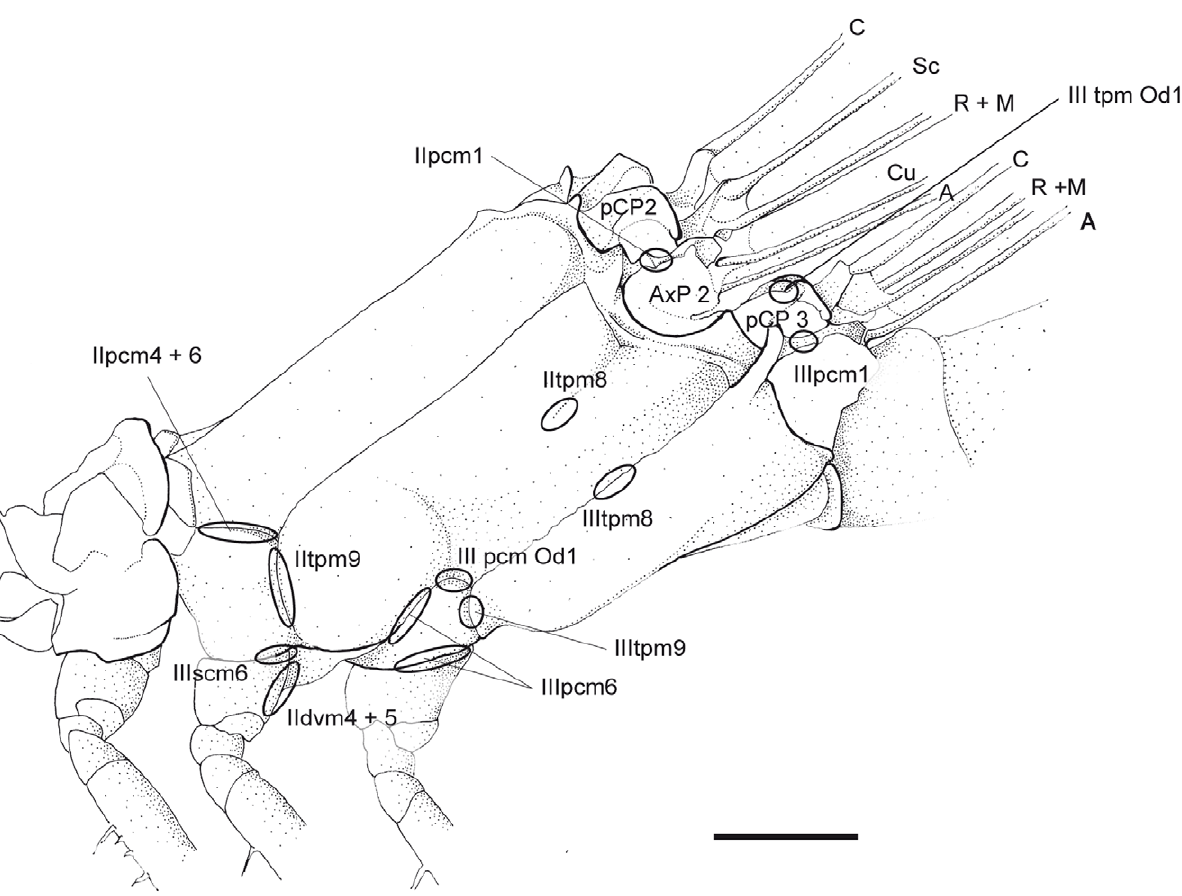
Figure 1. Thorax of P.nymphula , muscle attachment points as seen from outside, left, lateral view. Abbreviations: A – anal vein, AxP – axillary plate, C – costa, Cu – cubitus, M – media, pCP – proximale costal plate, R – radius, Sc – subcosta.